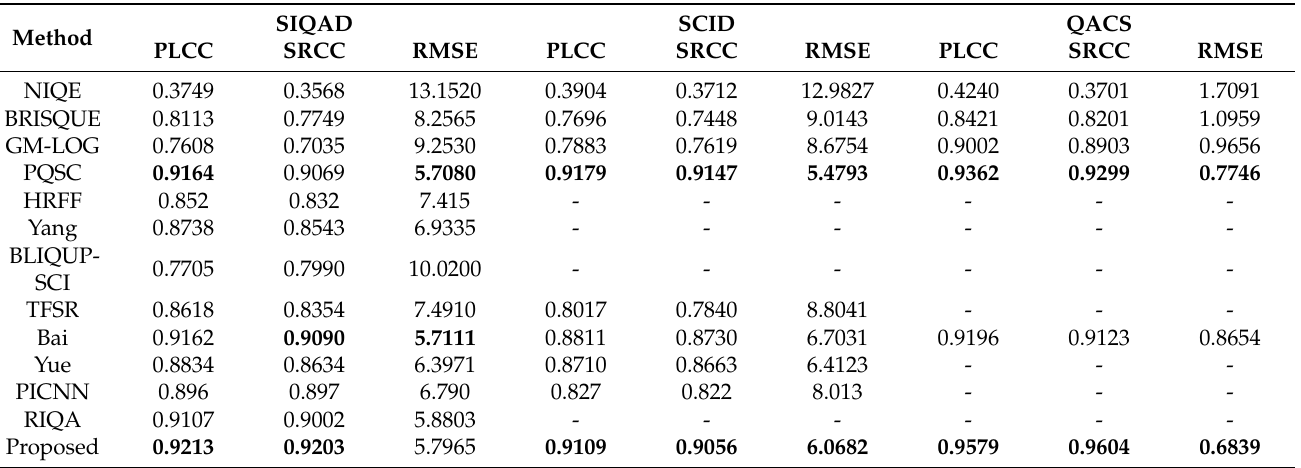
Table 2. Performance comparison results of different NR-IQA methods on the SIQAD, SCID, and QACS databases.